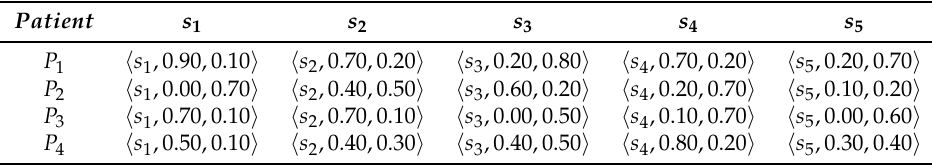
Table 5. The symptoms of the patients in Example